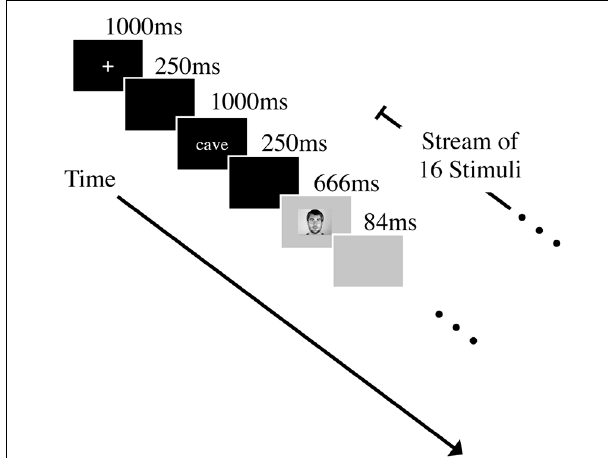
FIGURE 1 | Experimental format of an audio-visual trial. Each trial started with a fixation cross that was presented at the center of a black screen for 1000 ms.This was followed by a blank, black screen for 250 ms. Participants were then shown a printed target word (ball, done, cave, or tile) for 1000 ms. Another 250 ms pause preceded the presentation of the spoken stimuli. A stream of 16 spoken words was shown on each trial. Each stimulus was 666 ms, followed by a silent blank screen for 84 ms before the next stimulus was presented. Four word targets were pseudo-randomly placed at ordinal positions between the 1st and 16th stimuli (i.e., positions 2 to 15) such that the targets were separated by at least one distracter. Participants were instructed to press the space bar as quickly and as accurately as possible whenever they recognized the target word. Stimuli either came from only one speaker (the single-talker condition) or from two speakers (the multiple-talker condition) depending on the